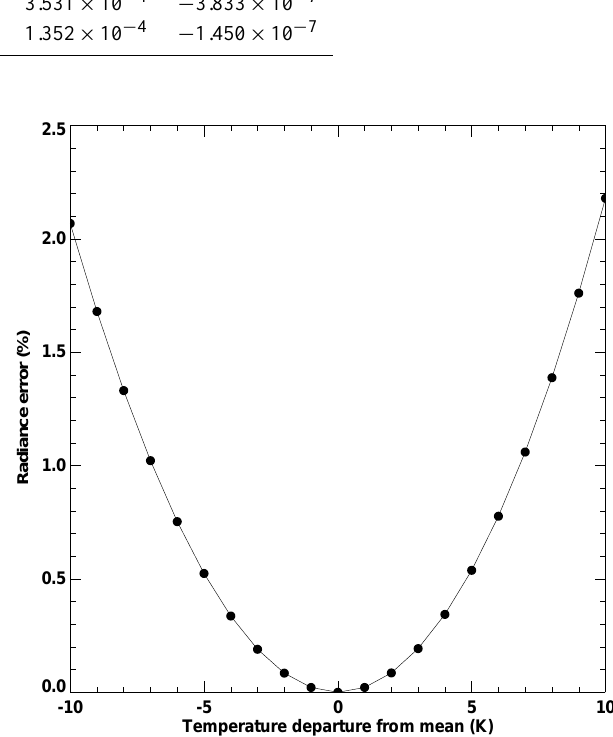
Figure 9. Radiance error (in %) versus departure from the mean FIGURE 9. Radiance error (in %) versus departure from the mean temperature (K) caused by approxi- mating the radiances using a 1st order Taylor series expansion about a mean temperature. temperature (K) caused by approximating the radiances using a first-order Taylor series expansion around a mean